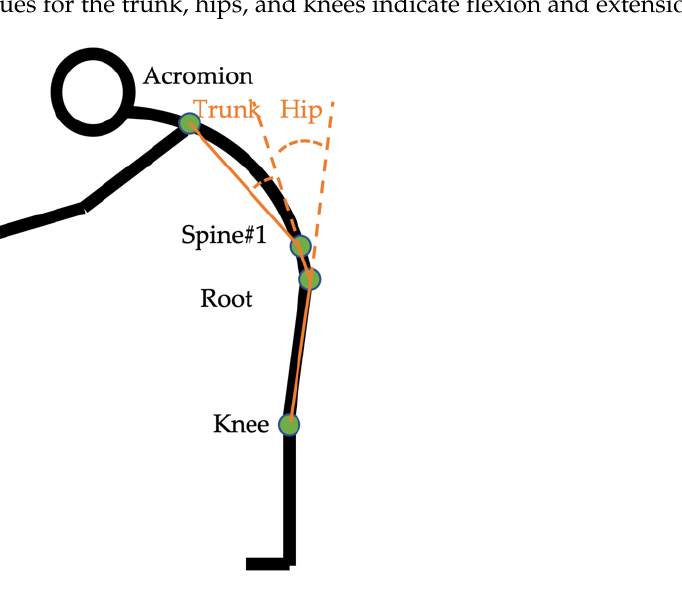
Figure 4. The definition of trunk and hip angles in the digital human model.